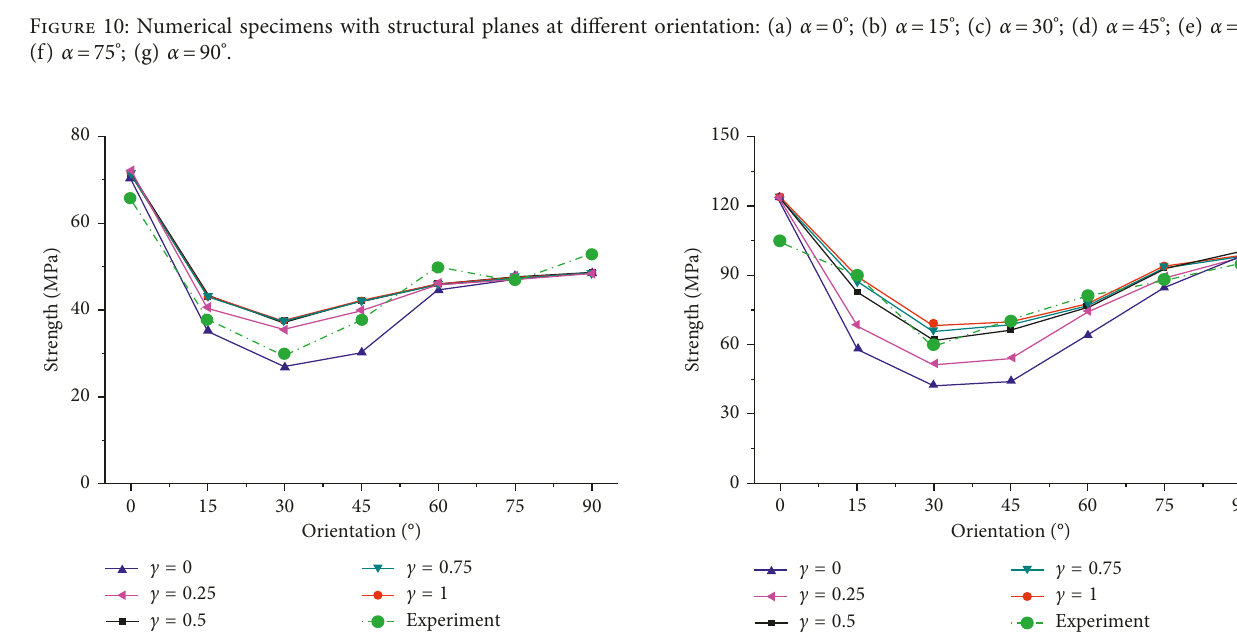
Figure 11: Uniaxial compressive strength with different micro- parameters on material interface.